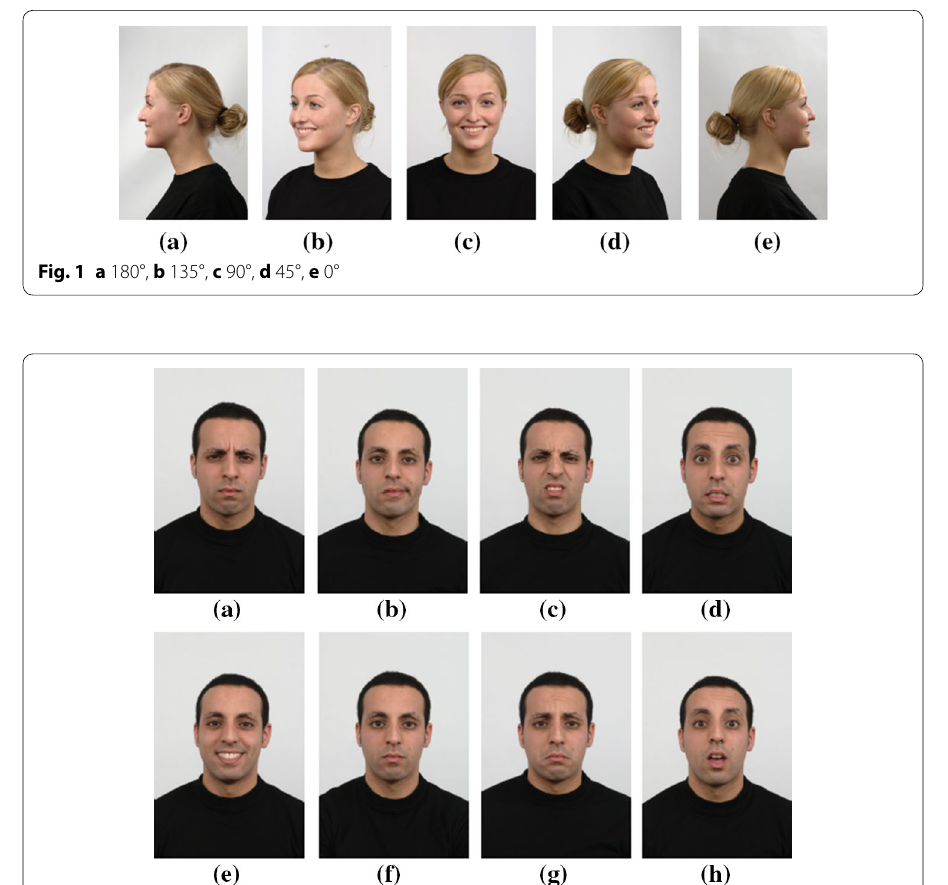
Fig. 2 Eight different emotions: a angry, b contemptuous, c disgusted, d fearful, e happy, f neutral, g sad, h